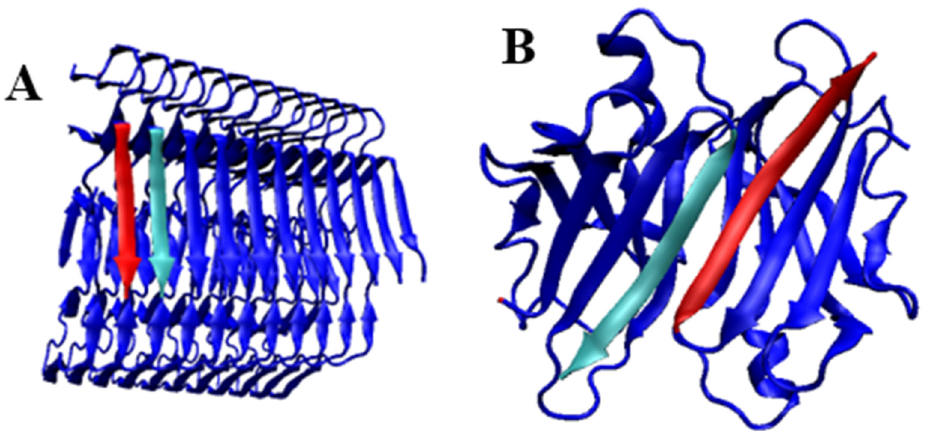
Figure 12. Arrangement of two β -strands in the β -sheet layout—the same chain fragments distin- guished by colour—transthyretin structure. ( A )—parallel in fibril (6SDZ); ( B )—antiparallel in WT form dimer (1DVQ).